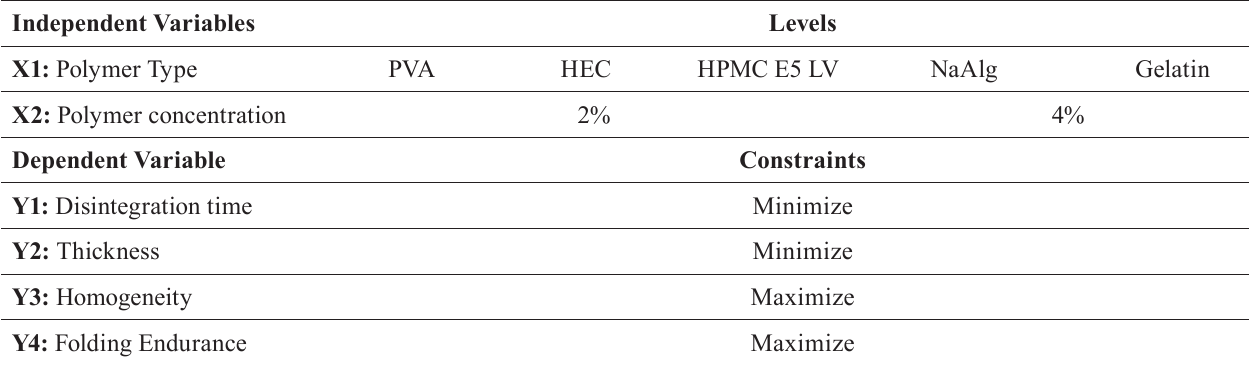
TABLE II - Full factorial design used to optimize SRT sublingual ODTs